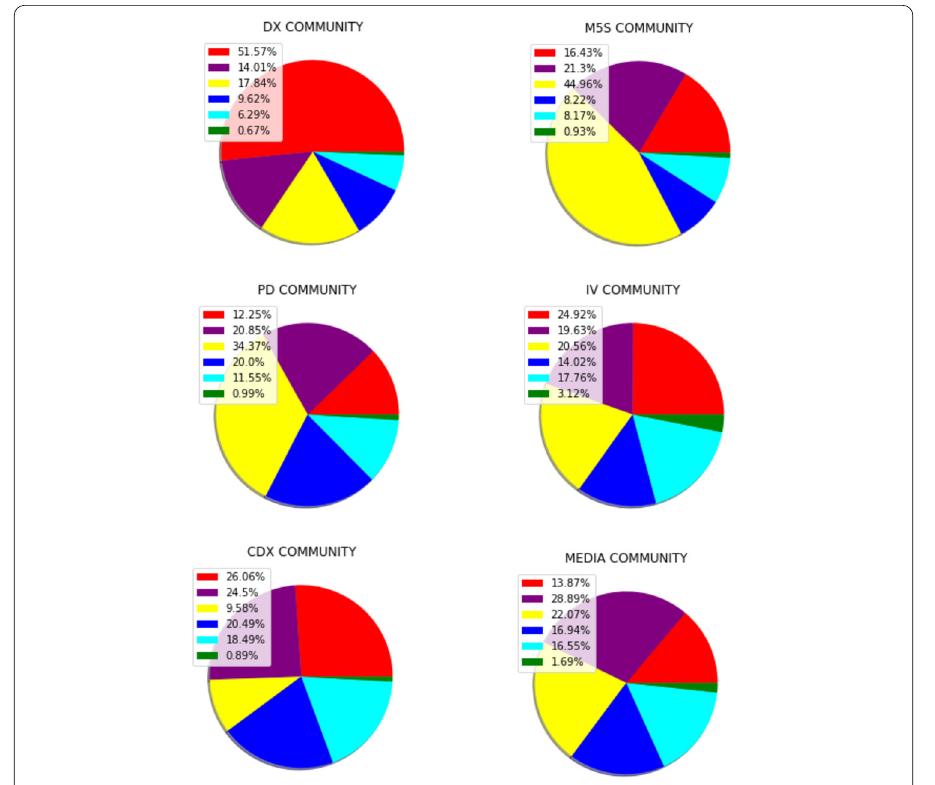
Figure 6 Hashtagconsumptionbydiscursivecommunity . The pie-charts describe the numbers of times a hashtag, belonging to one of the 6 communities described in the main text, has been shared by a user